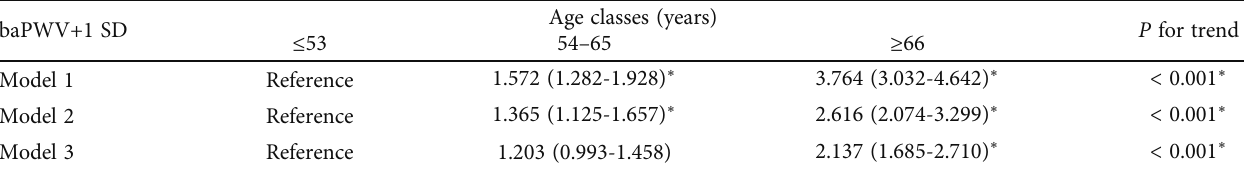
Table 3: Multivariable-adjusted di ff erences of baPWV values by three tertiles of age.